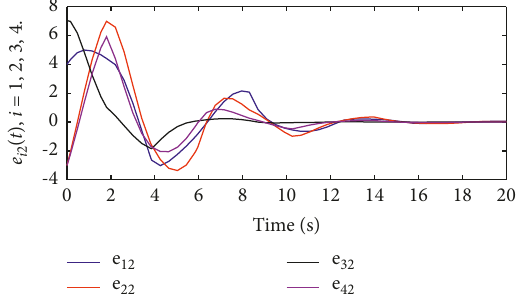
Figure 8: The state tracking error e